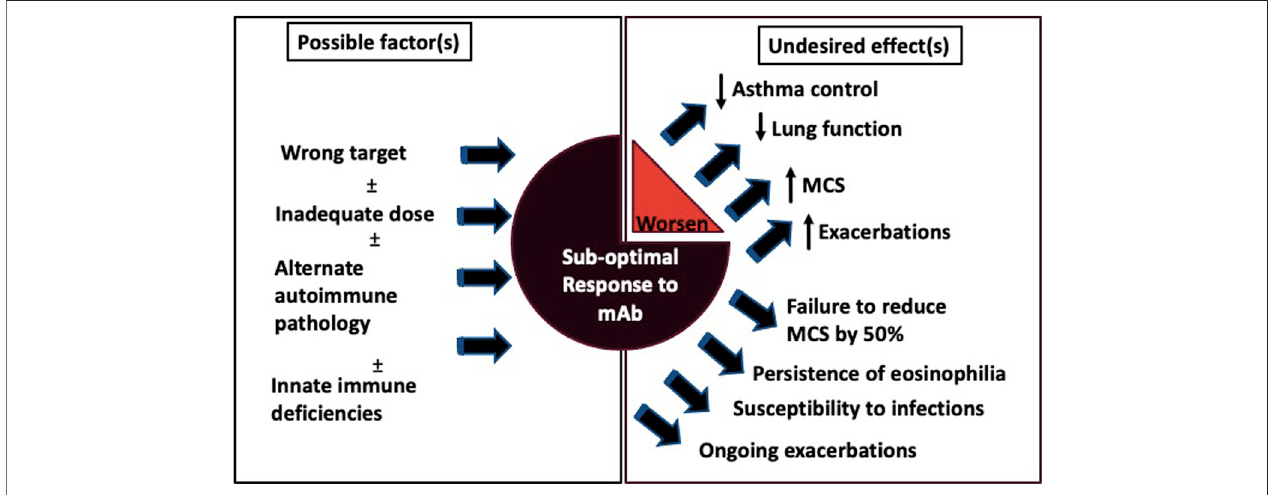
FIGURE 2 | Factors affecting optimal biologic response and clinical rami fi cations. The schematic addresses the primary factors that alone or in combination can lead to sub-optimal treatment response to currently approved monoclonal antibodies (mAbs) in severe asthma. The sub-optimal responses to mAbs can result in undesired clinical manifestations via , persistence and worsening of asthma symptoms, exacerbations, infections and decline in lung functions. Abbreviations: mAb: Monoclonal anitbody; MCS: Maintenance